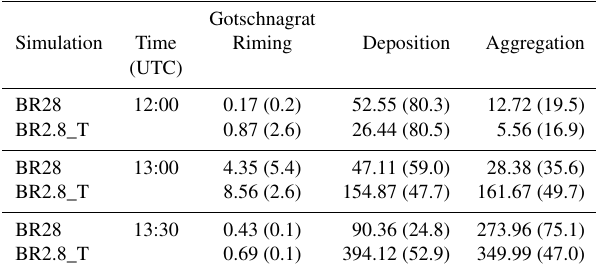
Table 2. Vertically integrated growth rates (milligrams per square meter per second; hereafter mgm − 2 s − 1 ) of ice over the lowest 700m at Gotschnagrat. In parentheses are the corresponding growth rate